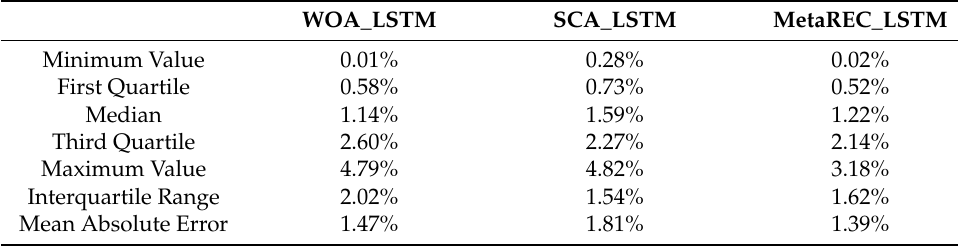
Table 5. Comparison of the results of the three methods.